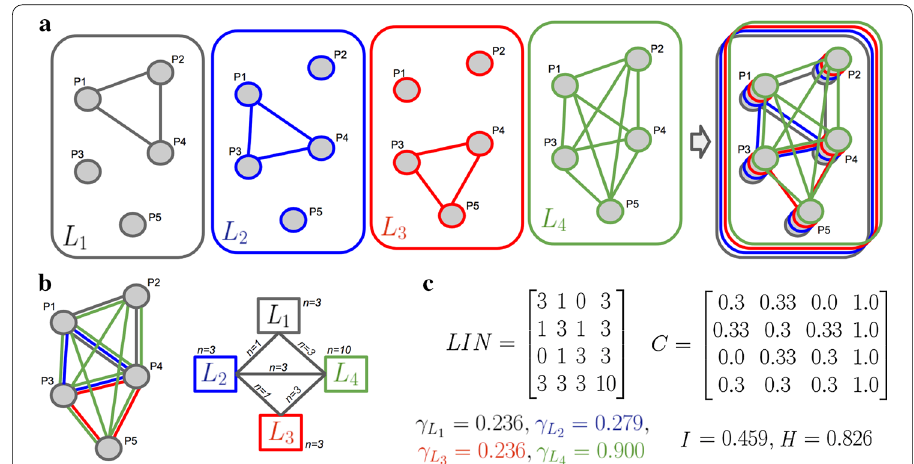
Fig. 1 A toy example of layer entanglement computation: a separated layers considered in a multiplex network; b constructing the layer interaction network from the example; c measuring entanglement from the